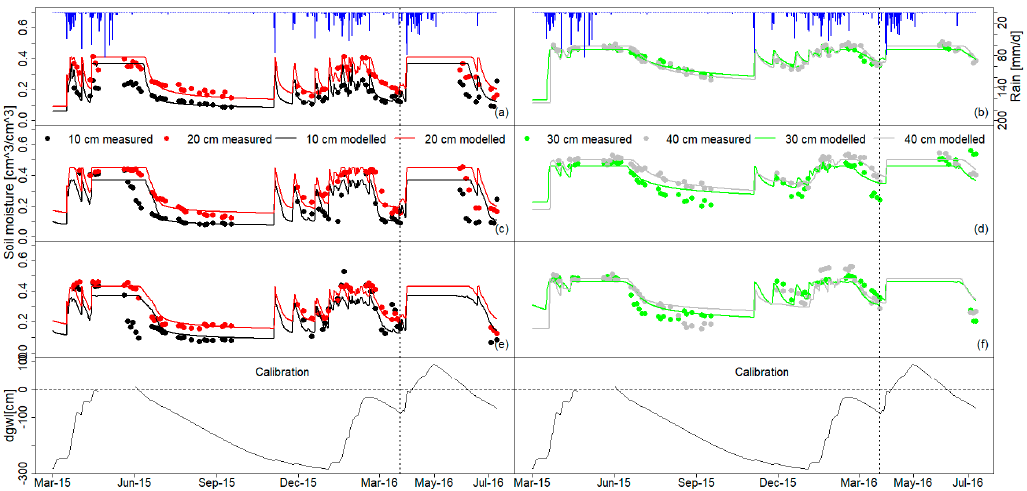
Figure 4. Measured and modeled soil moisture content after calibration at the four plots for the middle zone. ( a , b ) plot PM_3; ( c , d ) plot PM_5; ( e , f ) plot PM_7. dgwl; measured depth to groundwater level. Table 4. Statistical measures of the Hydrus-1D model performance for simulations of soil moisture content at the middle zone after calibration. Statistic Measure